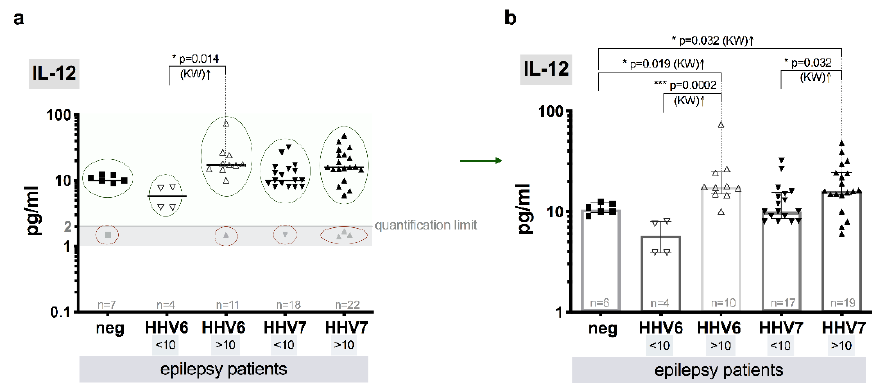
Figure 4. Comparative blood plasma level of IL-12 in epilepsy patients: ( a ) scatter plots with medians of HHV-6 and HHV-7 negative (neg) and HHV-6 and HHV-7 positive viral load ( < 10 and > 10 copies / 10 6 cells), gray symbols (marked with red ovals) show values below quantification limit (QL); ( b ) scatter plots with bars (medians with IQR) that represent values above QL (marked with green ovals in a) of HHV-6 and HHV-7 negative (neg) and HHV-6 and HHV-7 positive viral load ( < 10 and > 10 copies / 10 6 cells), values below QL are excluded; asterisks and respective p represent significance level of differences between the groups (KW — Kruskal – Wallis test).